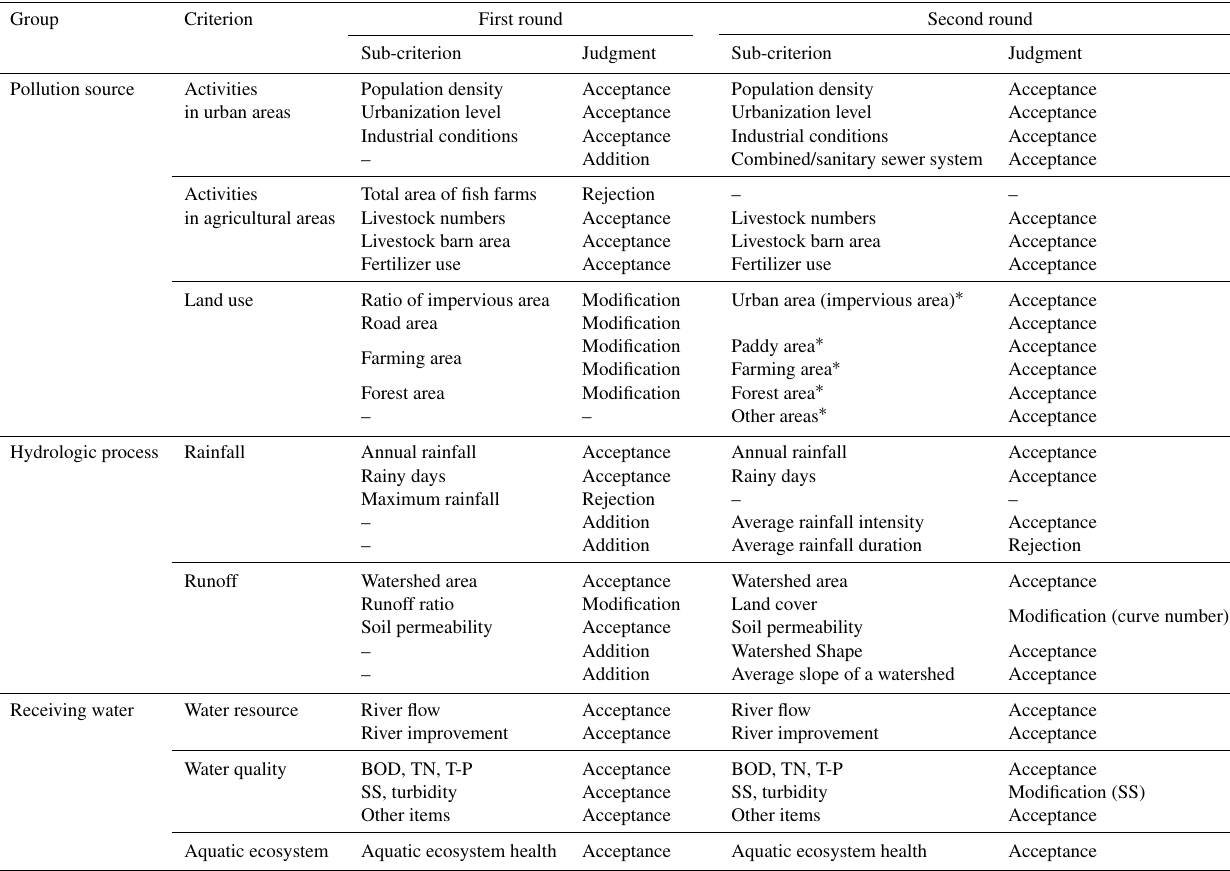
Table 2. Determination of the evaluation framework by the Delphi